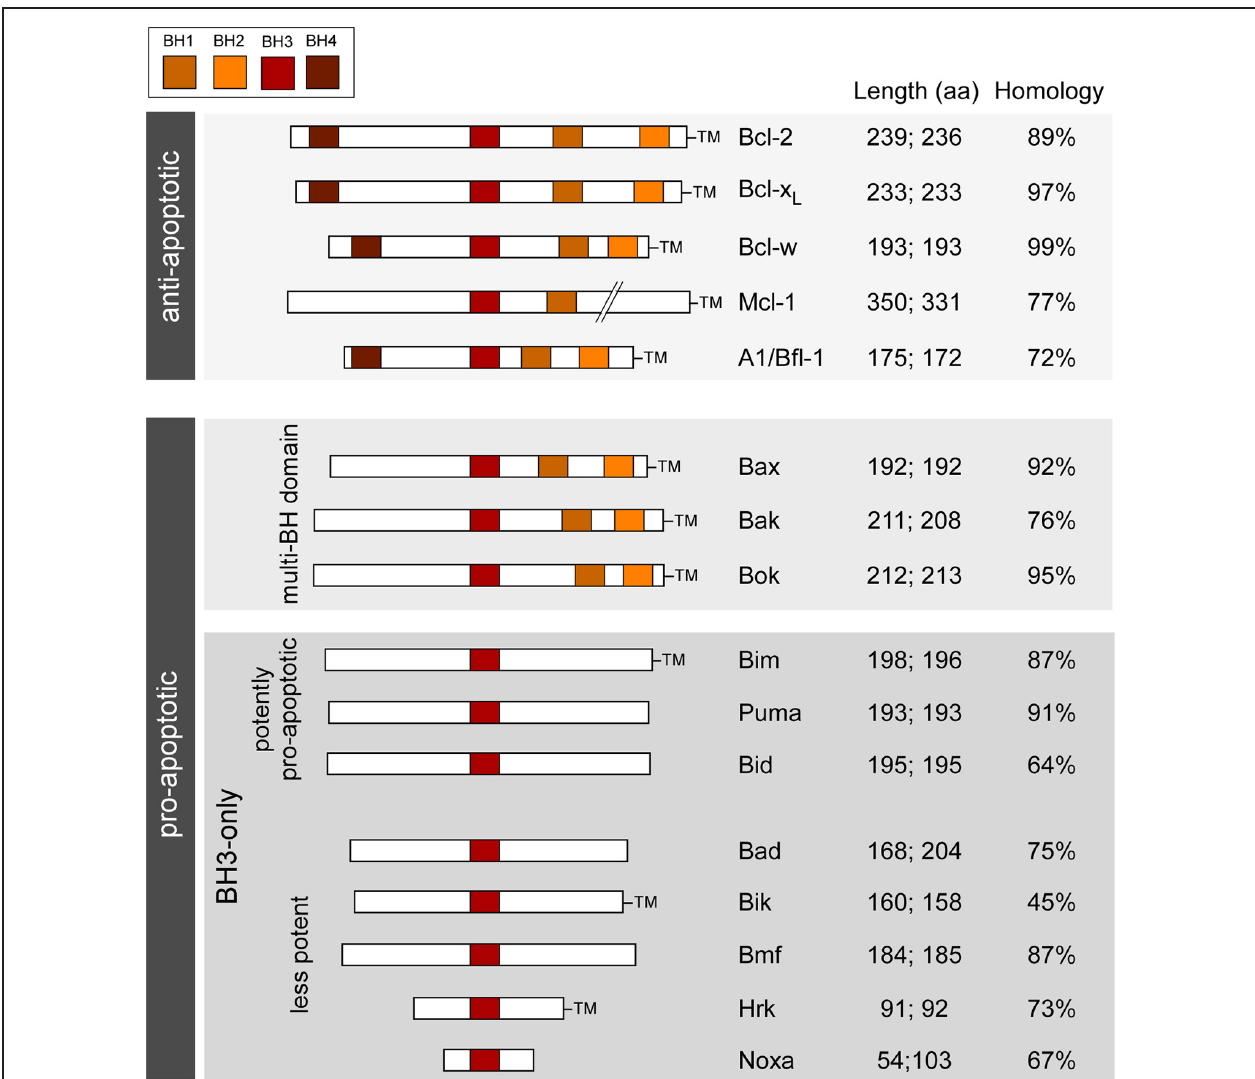
FIGURE 1 | Bcl-2 family; organization, functions, and characteristics. Schematic shows the main Bcl-2 family proteins in humans and mice along with the main conserved structural motifs (BH domains), grouped according to function and depicting amino acid length and homology between